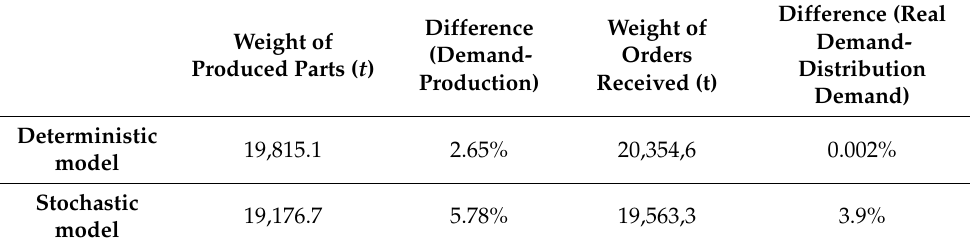
Table 13. Comparison of the real number of products. Difference (Real Weight of Difference Demand- Weight of Orders (Demand- Distribution Produced Parts ( t ) Received (t) Production) Demand) Deterministic 19,815.1 2.65% 20,354,6 0.002% model Stochastic model